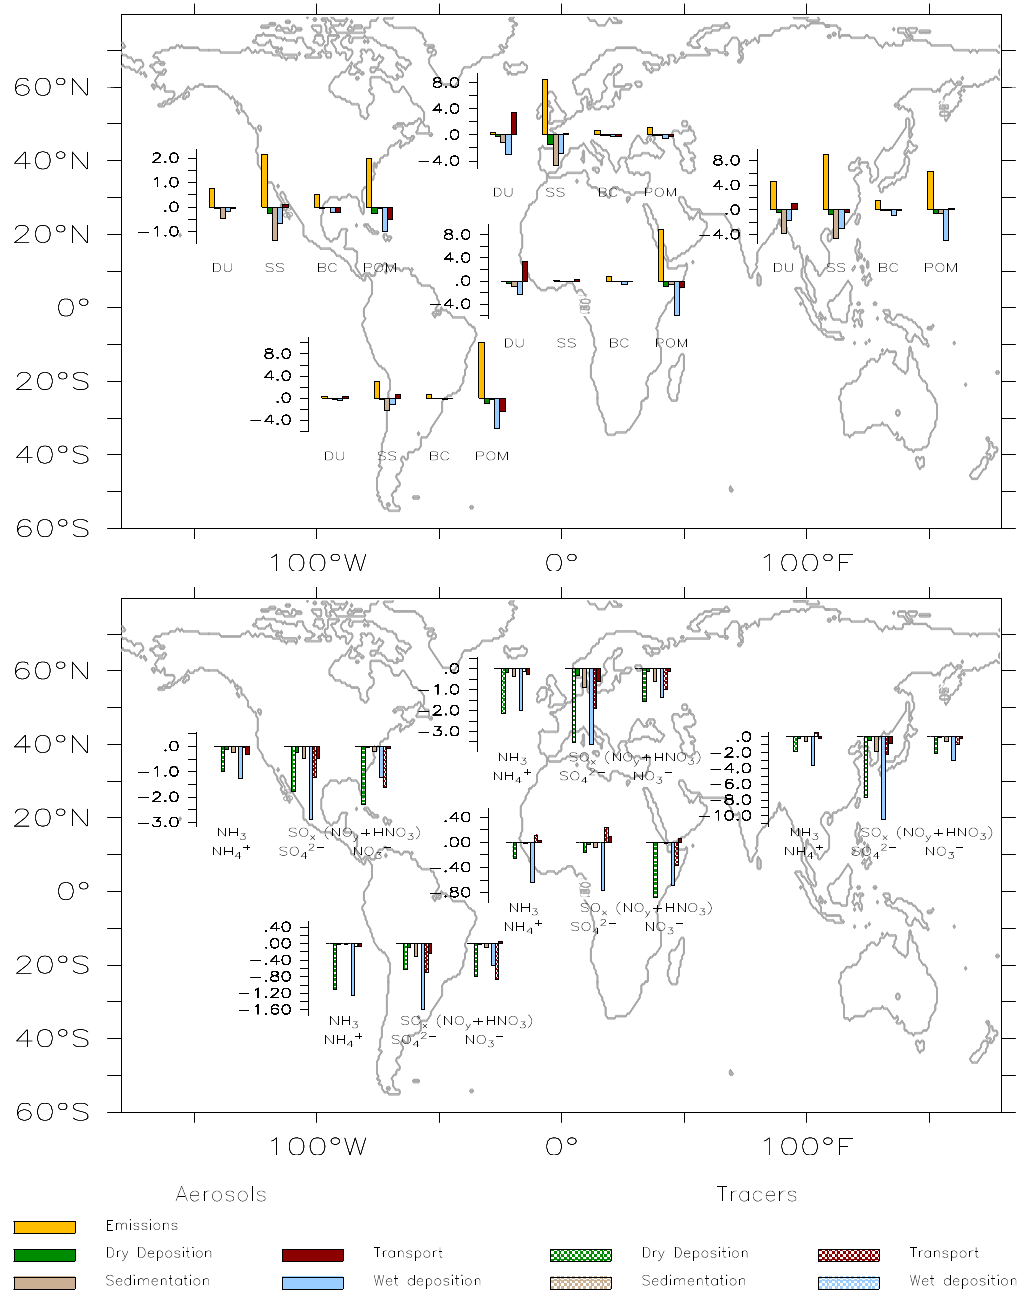
Fig. 15. Budget of different aerosol (and precursors) species as in Table 5, displayed by regions. The colour code denotes the process while the positive (negative) value is associated with a source (sink) of the component. Under the abscissa the components are listed: dust (DU), sea salt (SS), black carbon (BC) and particulate organic matter (POM). The units are all in Tgyr − 1 (TOP) and in GgNyr − 1 and GgSyr − 1 (BOTTOM). DU and SS are reduced by a factor of 10 for clarity. For the non bulk aerosol species the emissions were removed for clarity. Please note the different vertical axis in each